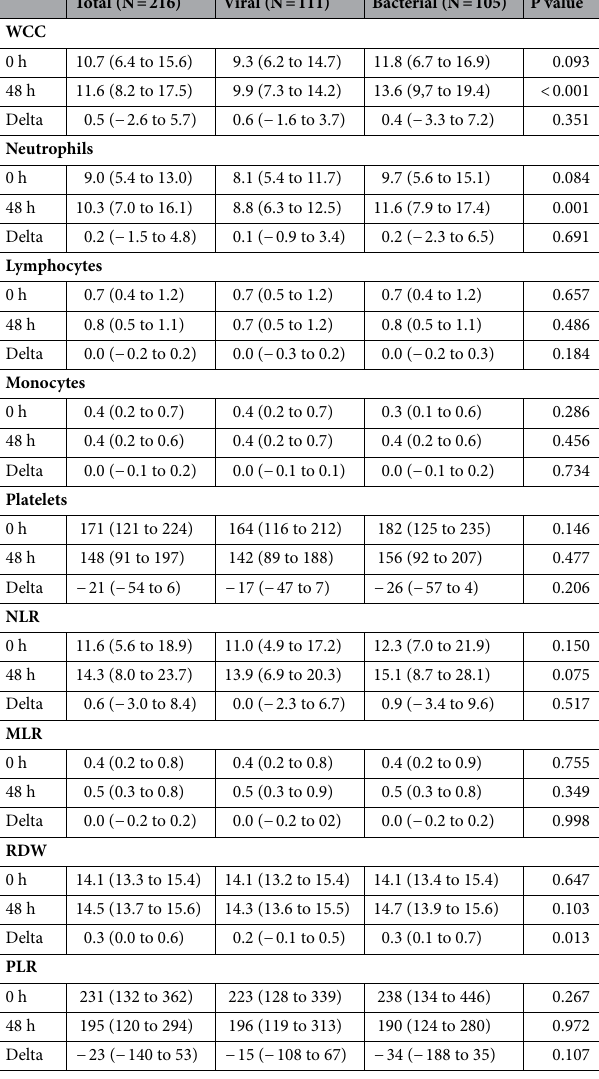
Table 5. Comparison of laboratory parameters between viral and bacterial pneumonia. The delta is defined by the difference between the 0 and 48 h data (48 h minus 0 h). WCC white cell count, NLR the neutrophil-to- lymphocyte ratio, MLR the monocyte-lymphocyte ratio, RDW the red cell distribution width, PLR the platelet- to-lymphocyte ratio.